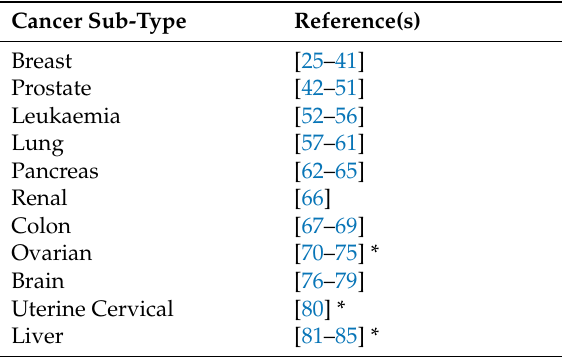
Table 1. Overexpression of SphK is causally linked to cancer.